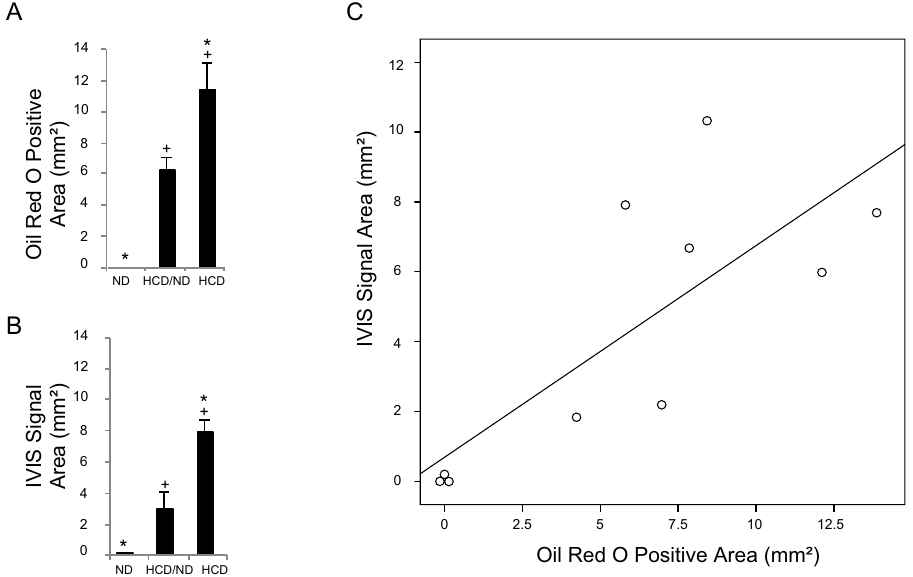
Figure 5. Atherosclerosis lesion areas are closely related to the in vivo iRFP signal areas. ( A ) ORO-positive areas and ( B ) in vivo IVIS signal areas in all three groups were measured by ImageJ software. * P < 0.05 versus the “ND group”, + P < 0.05 versus the “HCD/ND group” (Student’s t-test). (C ) A significant positive correlation was observed between the ORO-positive areas and the in vivo fluorescence signal areas at the level of P = 0.01. The data are from one representative experiment of at least two independent experiments. Quantified data are presented as the mean ±